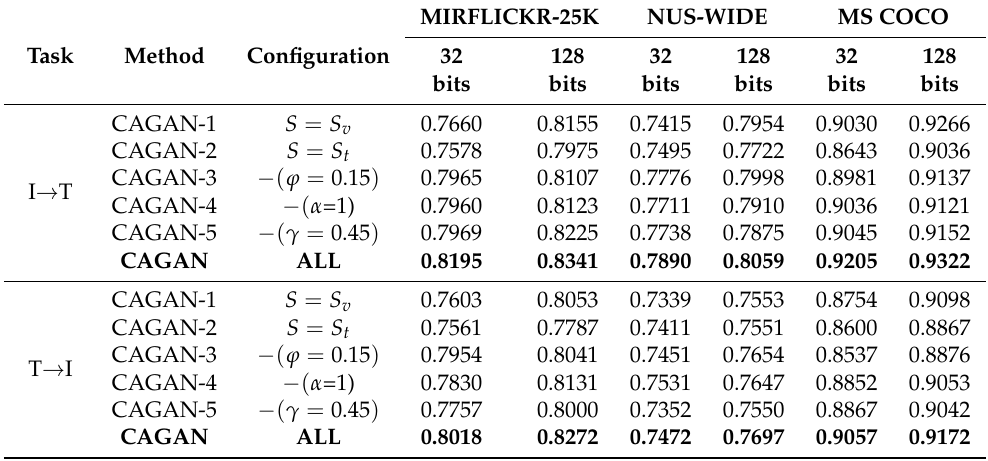
Table 5. The MAP@5000 results on image–text retrieval tasks (I → T indicates the image search text task and vice versa) at various code lengths and datasets. The best outcomes are highlighted in bold.